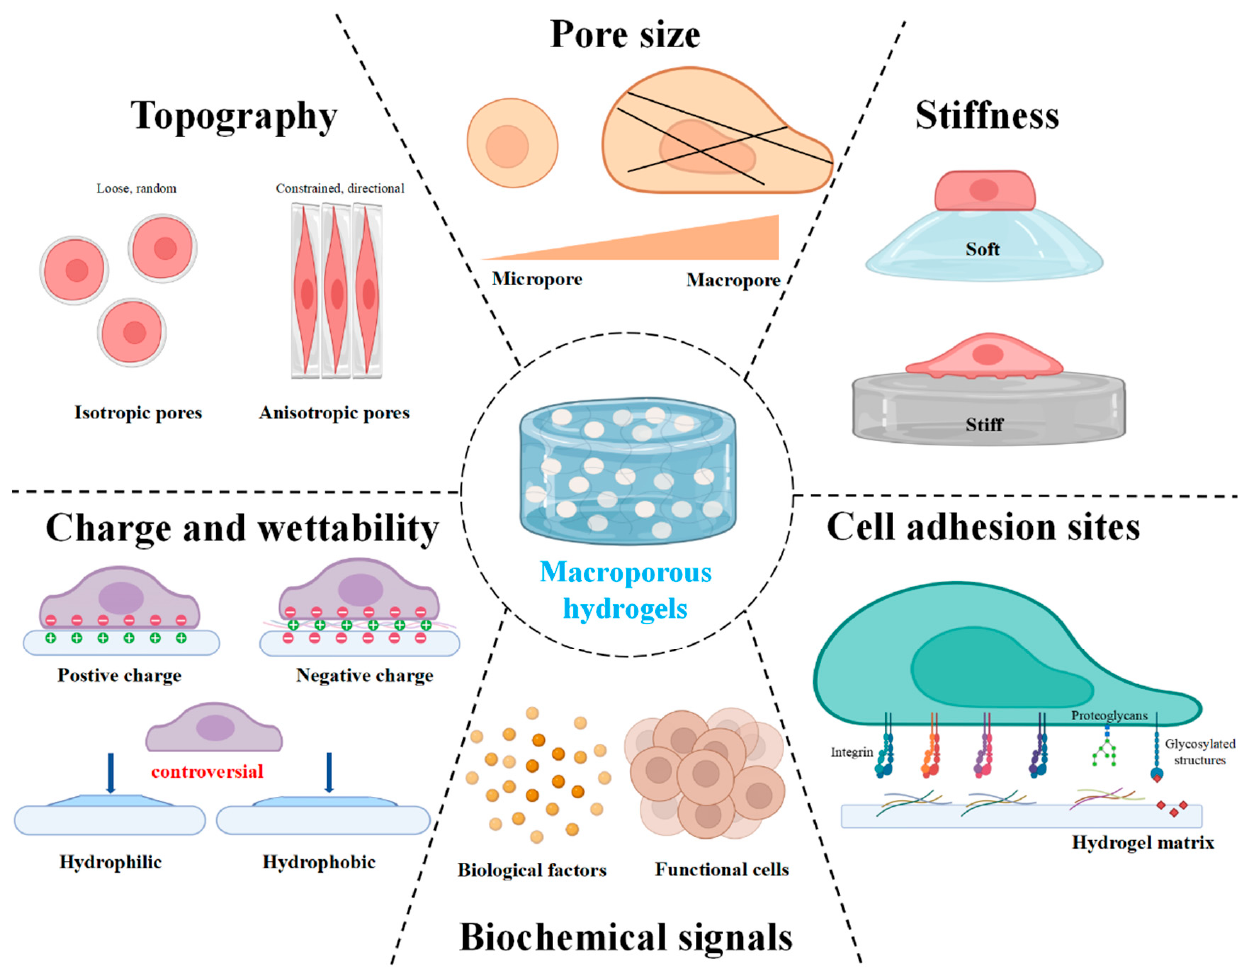
Figure 1. Designing macroporous hydrogels to modulate major factors in cell behavior. The Figure is made with biorender (https://biorender.com/ Accessed July 31, 2022).